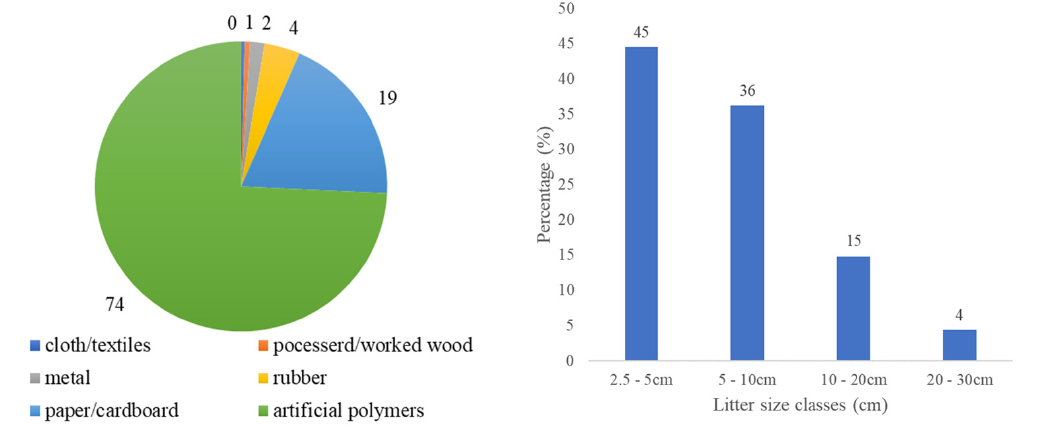
Figure 6. Percentage of materials of litter > 2.5 cm ( left ) and litter size classes ( right ) recorded at the Sochi River.